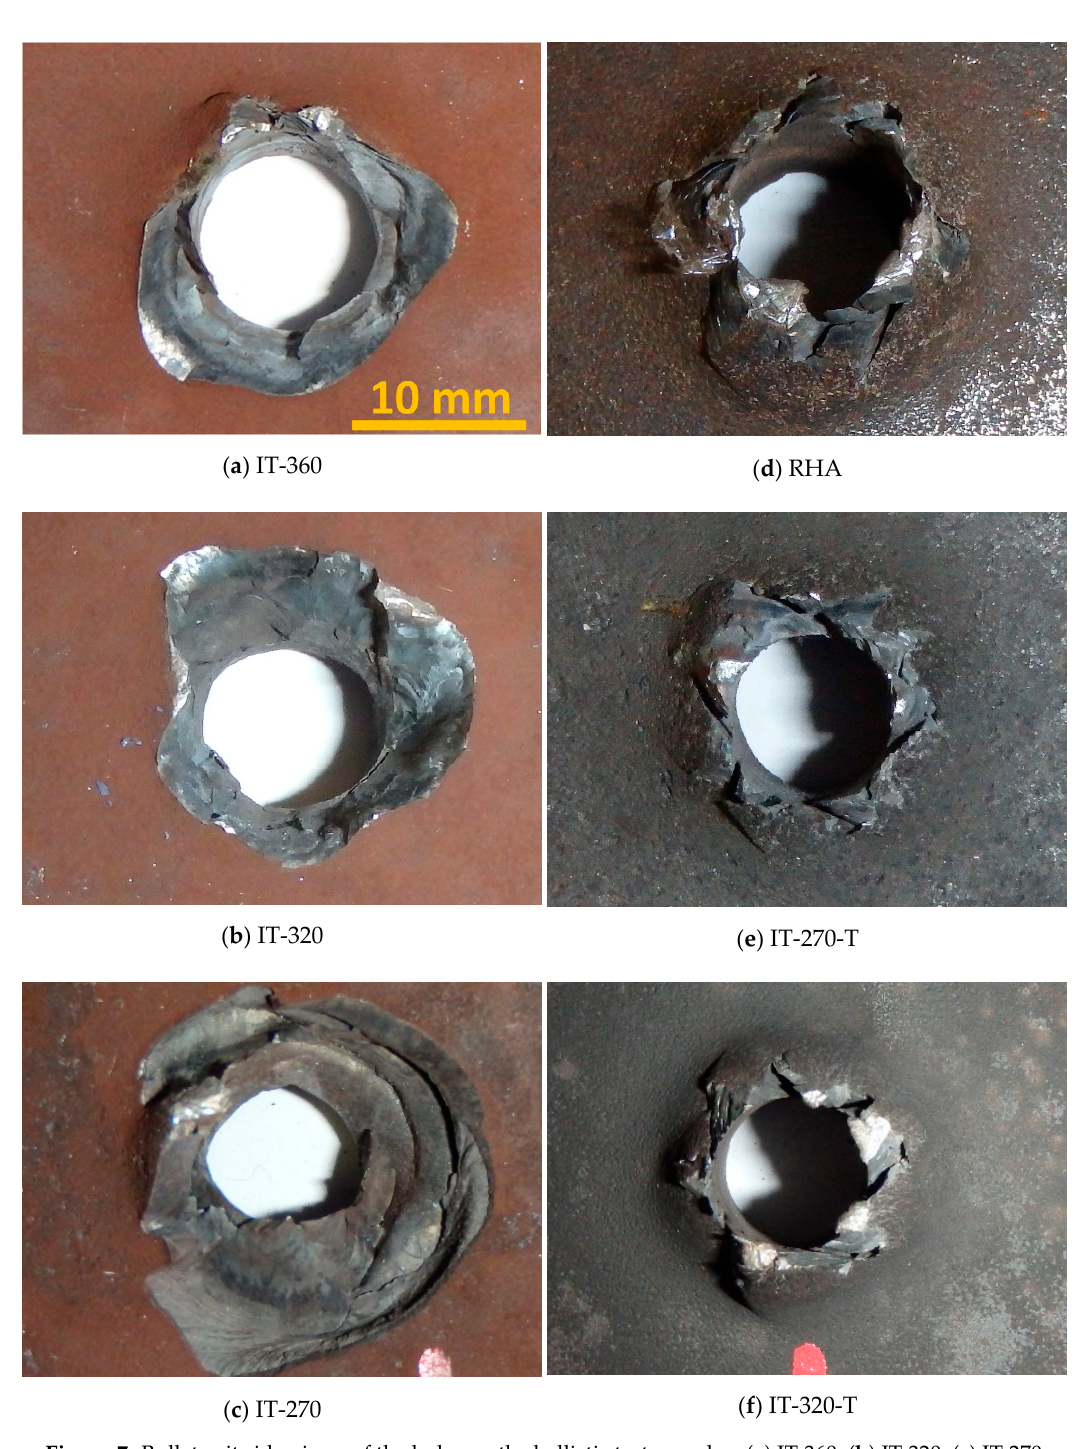
Figure 7. Bullet exit side views of the holes on the ballistic test samples: ( a ) IT-360, ( b ) IT-320, ( c ) IT-270, ( d ) RHA, ( e ) IT-320-T, and ( f ) IT-270-T.